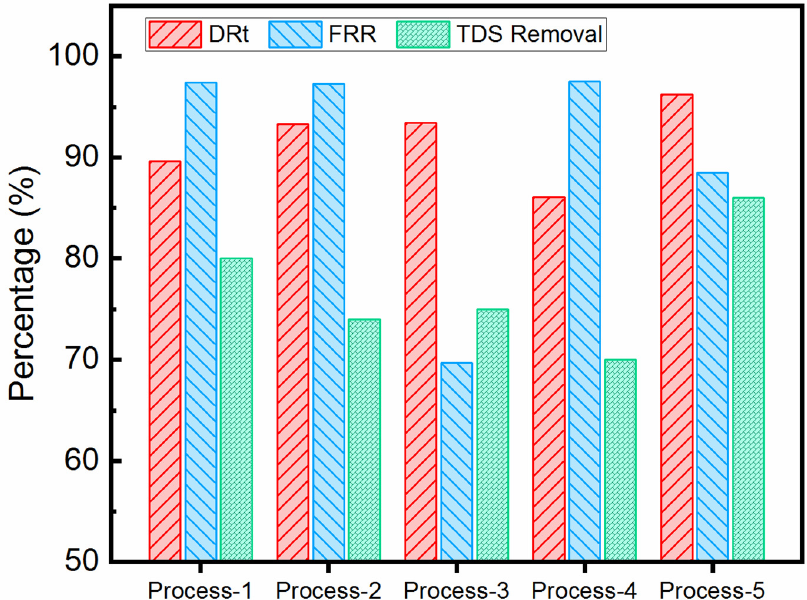
Figure 7. Comparison of total flux decline ( DR t ), flux recovery ration ( FRR ), and total dissolved solids (TDS) removal of different processes.